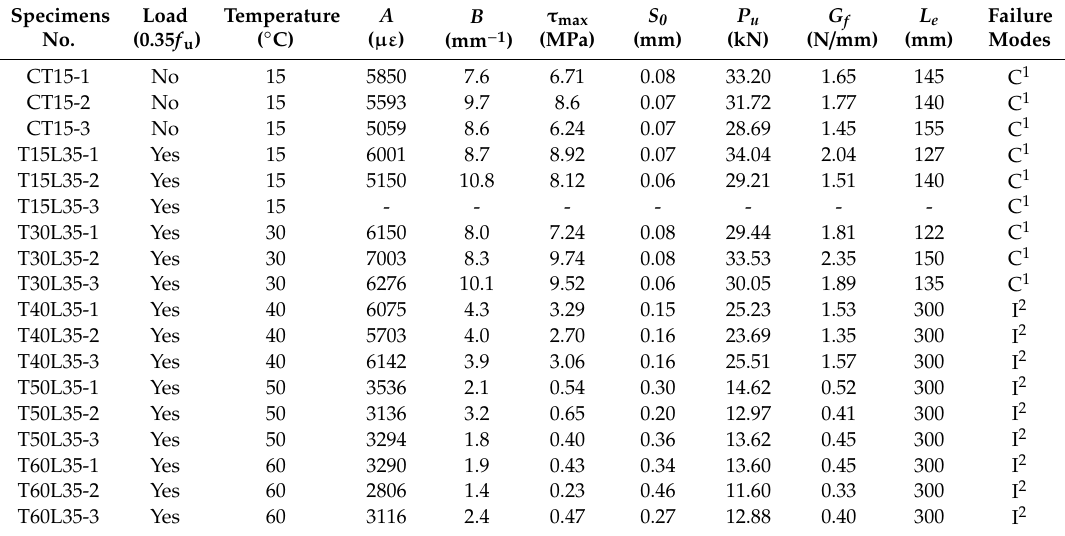
Table 1. Details of specimens and pullout bond test